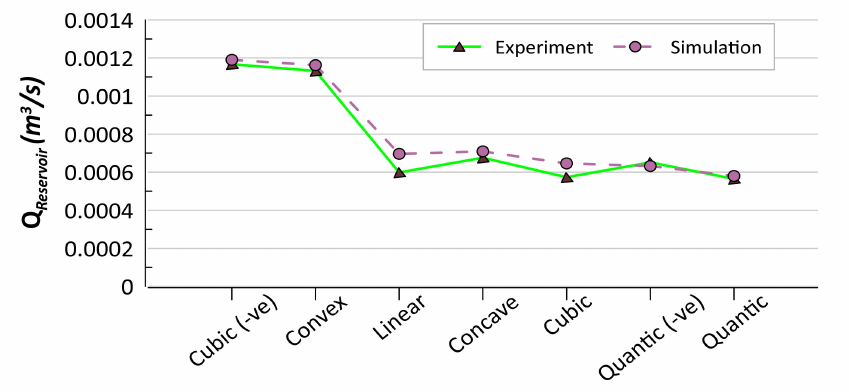
Figure 16. Overtopping rate comparison between experiment and simulation for each ramp